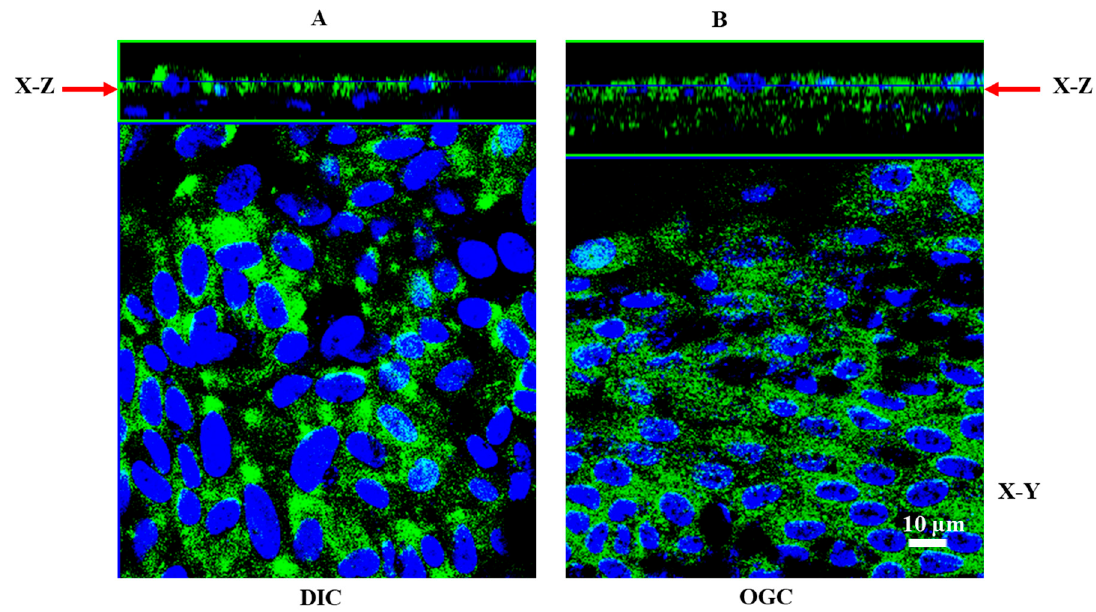
Figure 8. Localization of DIC and OGC in polarized RPE monolayers. RPE monolayers grown on Transwell filters were stained for OGC and DIC. The specimen was viewed on an LSM 770 laser-scanning microscope. ( A ) immunofluorescence staining of DIC in RPE monolayers showing predominant apical staining (X–Z plane). However, OGC has a wide distribution, expressed both in the apical as well as basolateral domains ( B ).